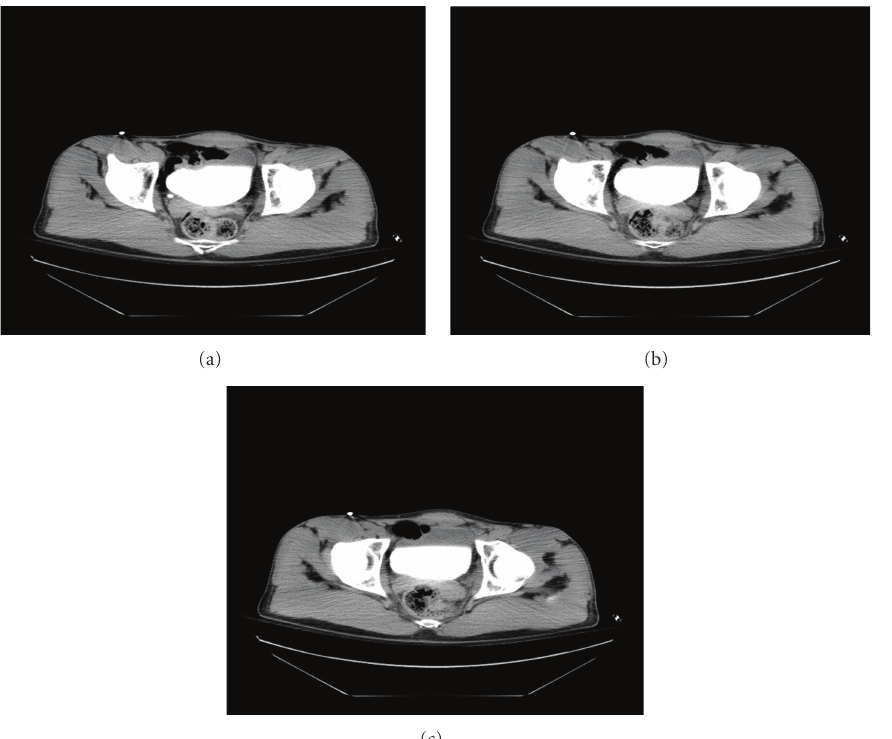
Figure 1: Contrast-enhanced CT scan (Siemiens). Contrast fills bladder without outflow. Urethra has not been revealed on these scans.